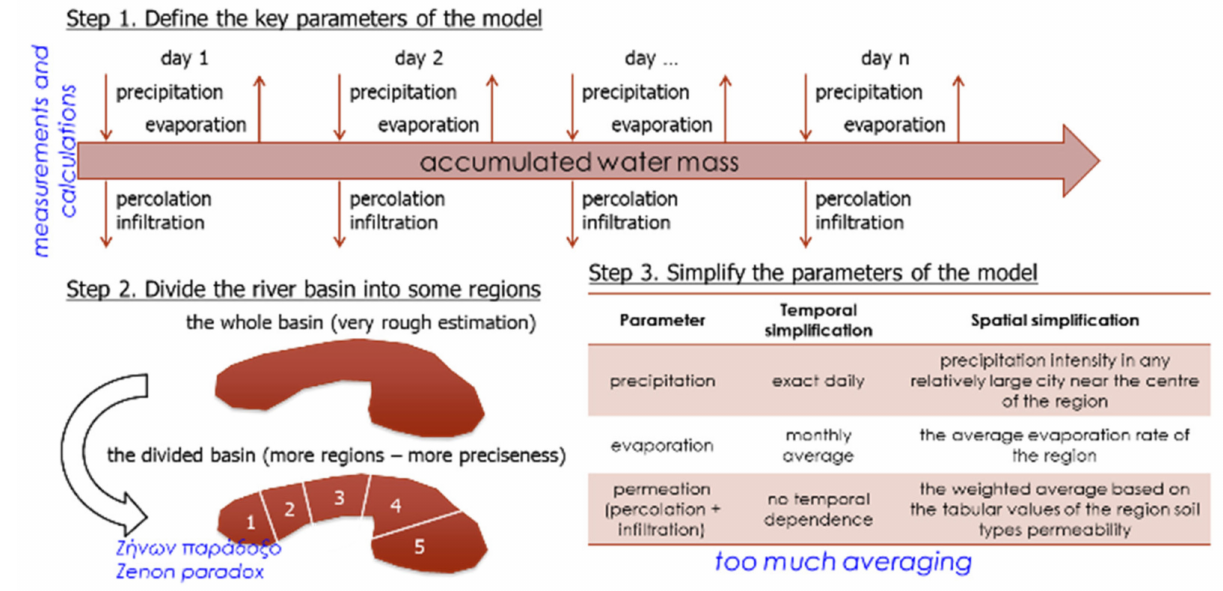
Figure 4. General schematic model of water accumulation and water-balance